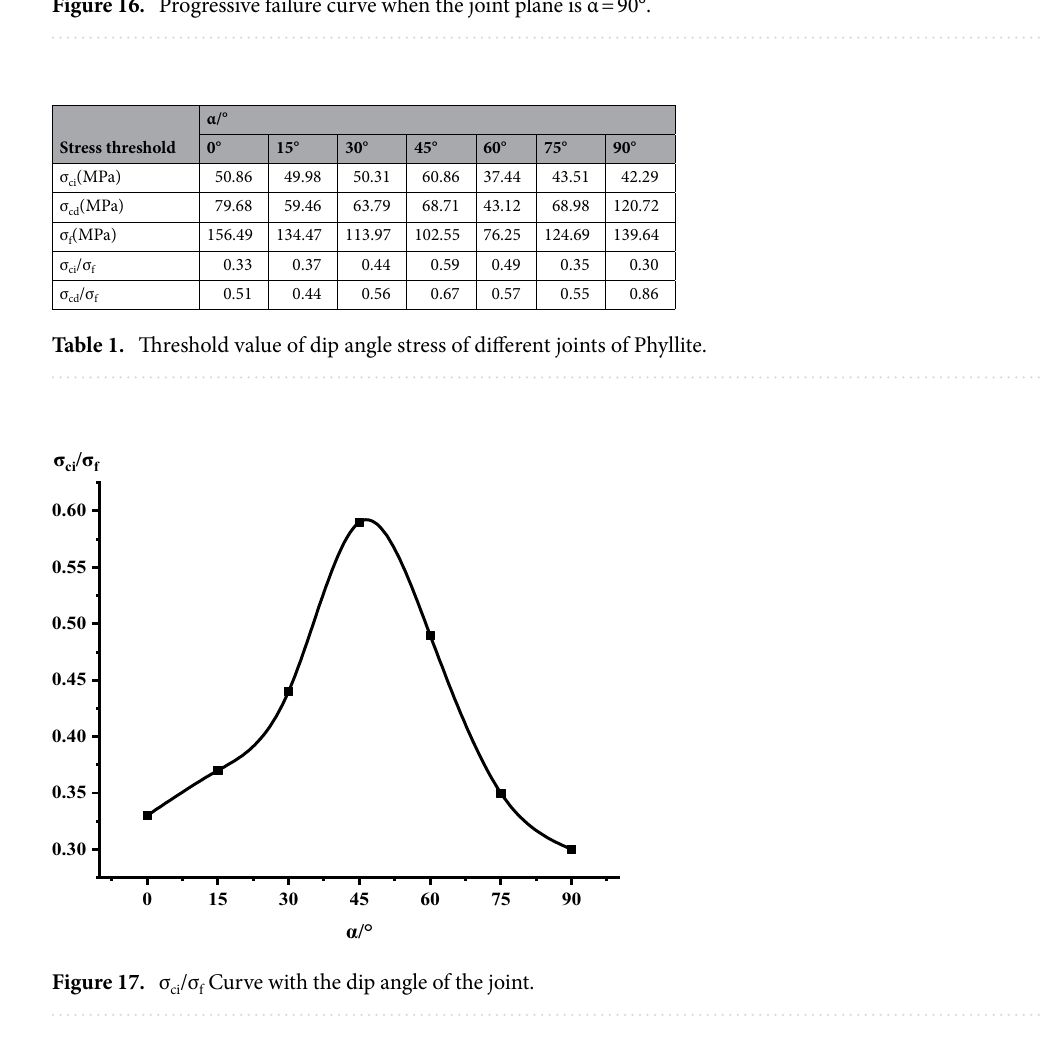
Figure 16. Progressive failure curve when the joint plane is α = 90°.